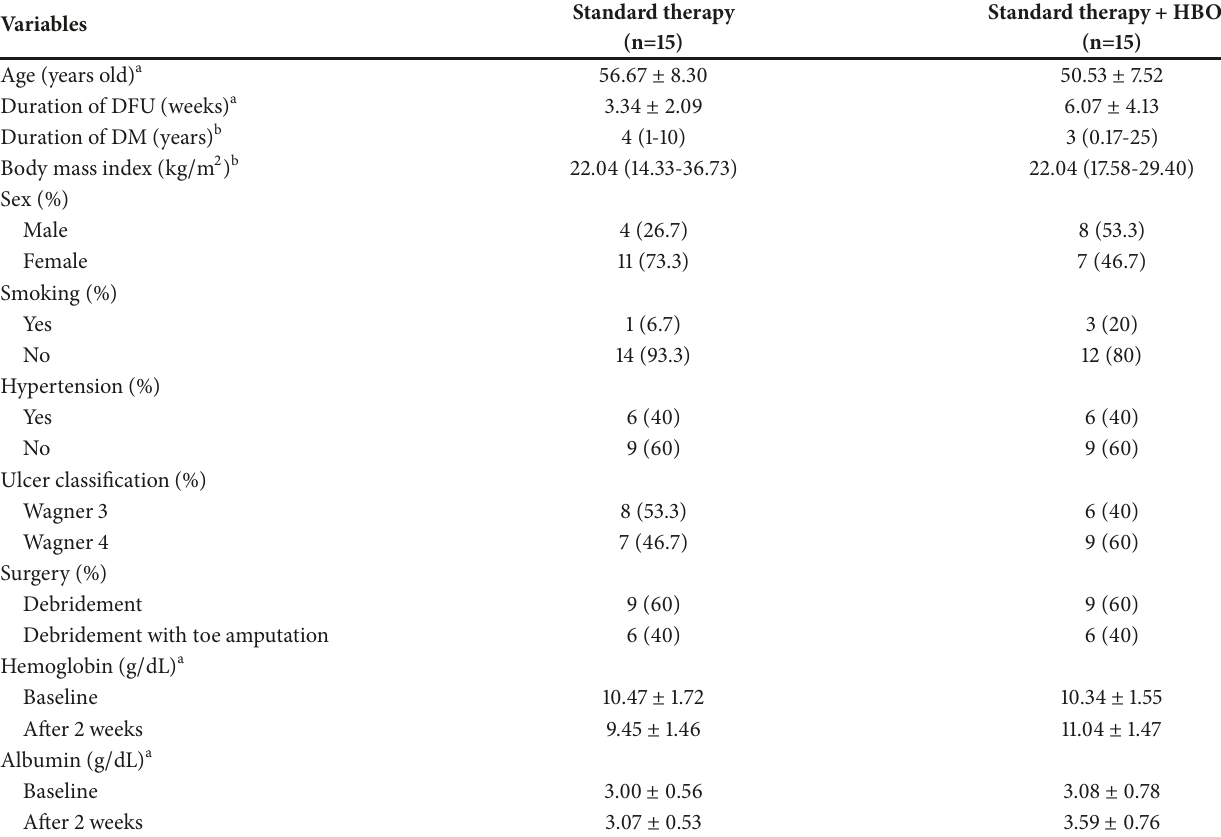
Table 1: Characteristics of patients.